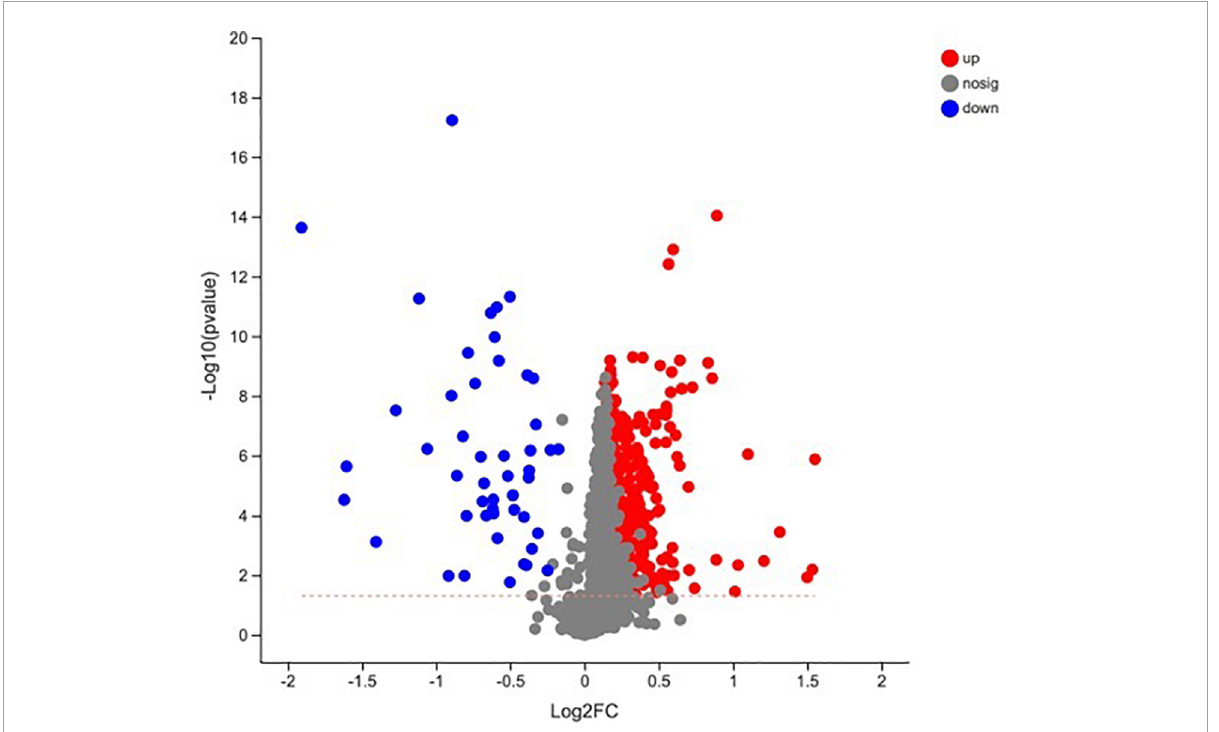
FIGURE5 Volcano plot analysis of the metabolites in sainfoin silage (CK 60, control group after 60 days of ensiling; PEG 60, PEG treated group after 60 days of ensiling).